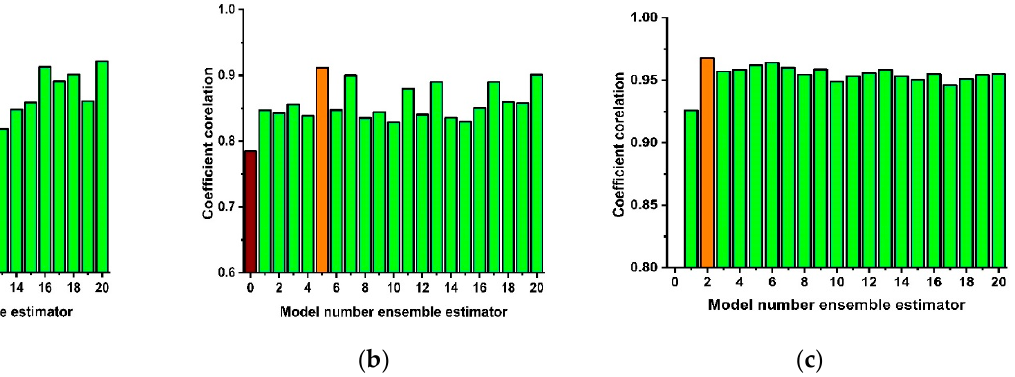
Figure 3. Ensemble models with various number of ensemble estimators; ( a ) SVR-bagging; ( b ) SVR-boosting; ( c ) Random forest. Table 4. Analysis method for optimum sub-models.